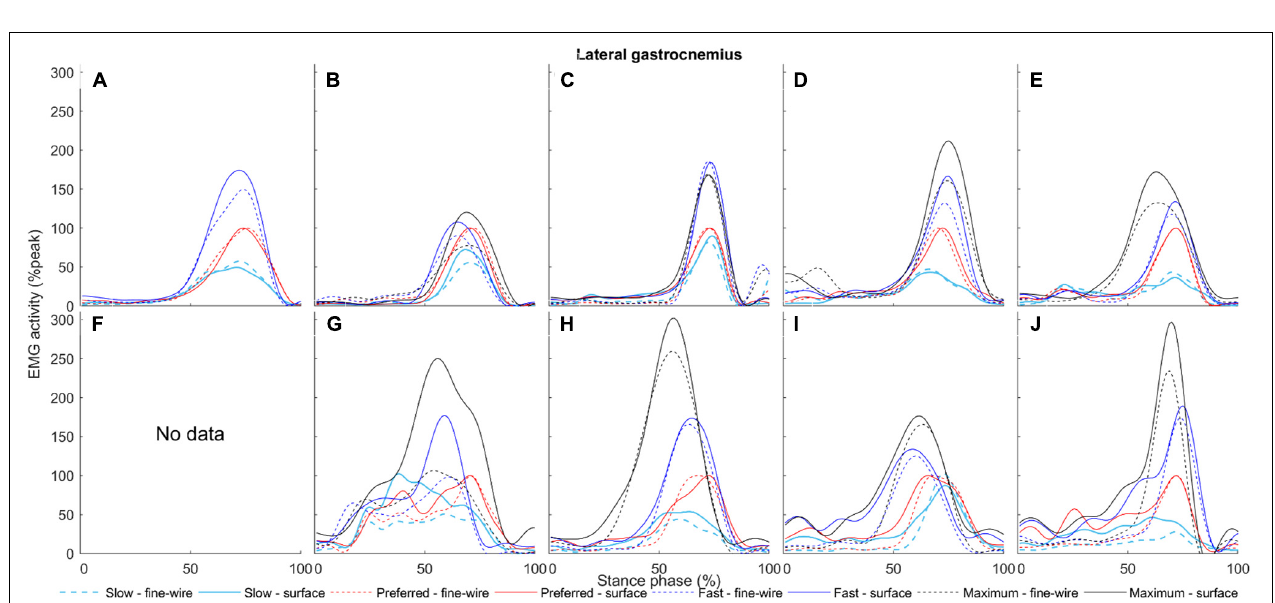
FIGURE 9 | Medial gastrocnemius surface (solid) and intramuscular (dashed) electromyography (EMG) activity at slow, preferred, fast, and maximum walking speeds (1.01 ± 0.13, 1.43 ± 0.19, 1.84 ± 0.23, and 2.20 ± 0.38 m s − 1 , respectively) in the stance phase for each individual ( A–J , respectively). The amplitudes of smoothed and time-normalised EMG curves were normalised to peak activity in preferred speed walking (%peak). Each curve represents the average of all steps (number of steps included in the analysis were 14 ± 3, 12 ± 3, 11 ± 2, and 9 ± 1, median ± interquartile range, at slow, preferred, fast, and maximum walking speeds, respectively) at a given walking speed.